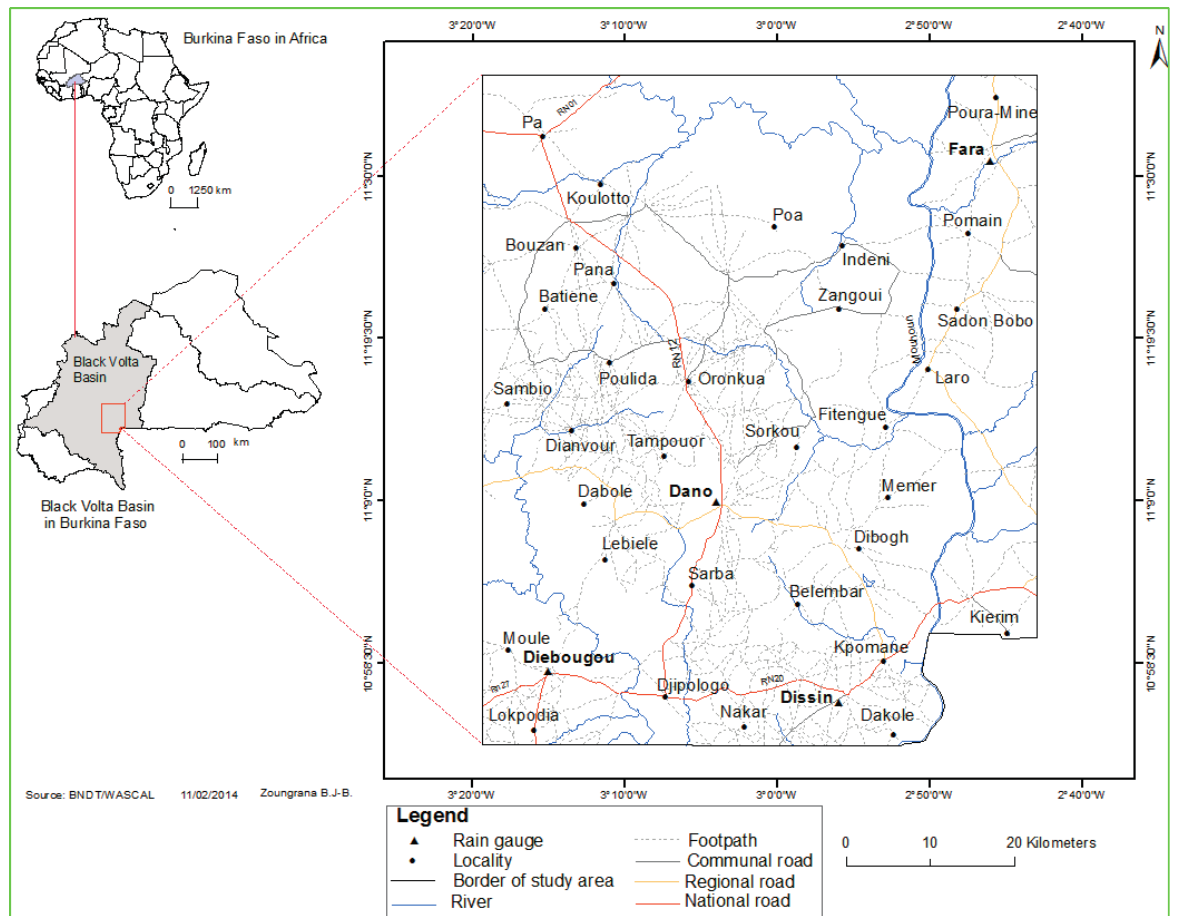
Figure 1. Situation of the study area and the rain gauges utilized for this